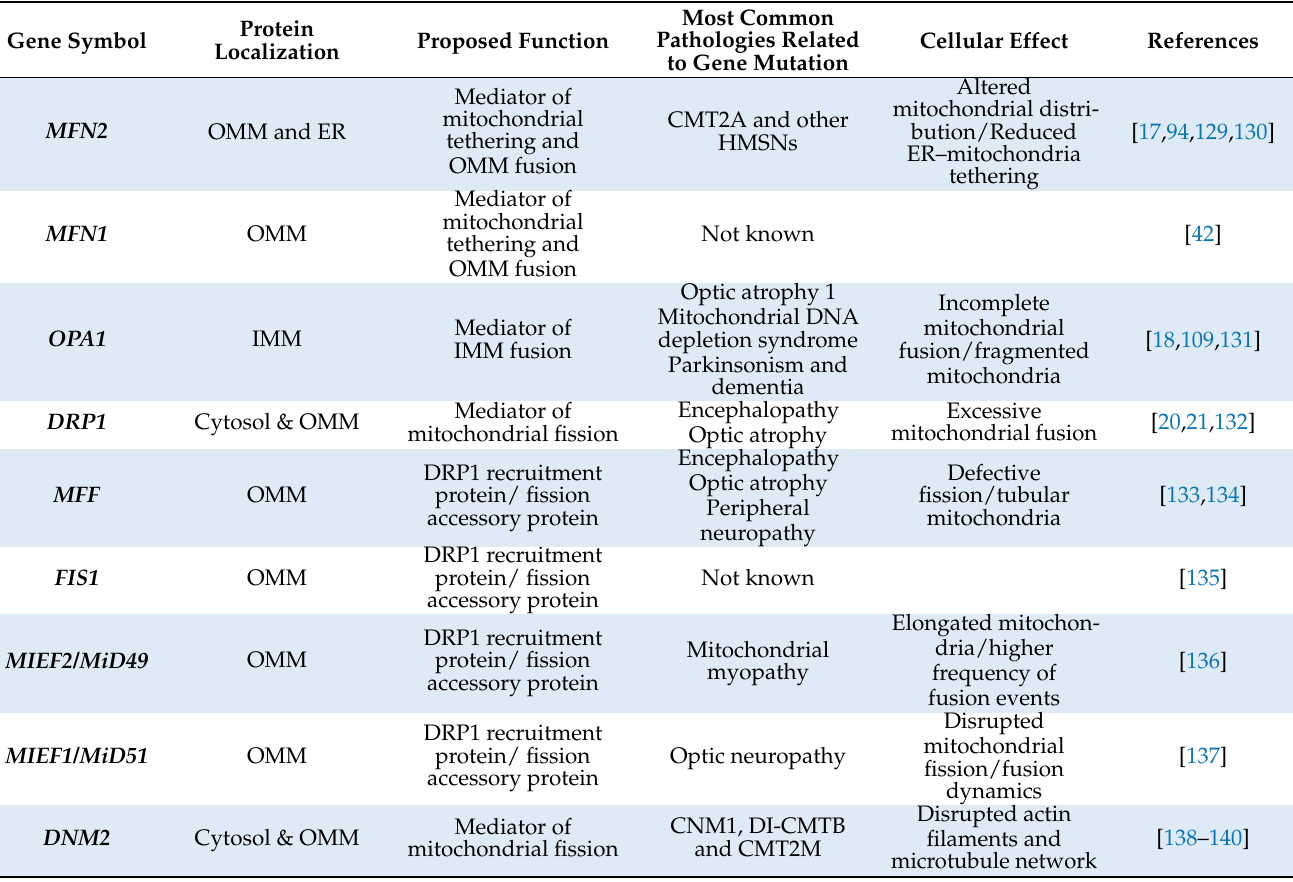
Table 1. Major mitochondrial fusion and fission effectors in mammals and associated diseases. MFN1/MFN2, mitofusin-1 and -2; OMM, outer mitochondrial membrane; IMM, inner mitochondrial membrane; ER, endoplasmic reticulum; CMT2A, Charcot–Marie–Tooth type 2A; HMSNs, hereditary motor and sensory neuropathies; OPA1, optic atrophy type 1; DRP1, dynamin-related protein-1; MFF, mitochondrial fission factor; FIS1, fission mitochondrial 1; MIEF1 /MIEF2, mitochondrial elongation factor 1 and 2; DNM2, dynamin 2; CNM1, centronuclear myopathy 1; DI-CMTB, dominant intermediate Charcot–Marie–Tooth disease type B; CMT2M, Charcot–Marie–Tooth disease axonal type